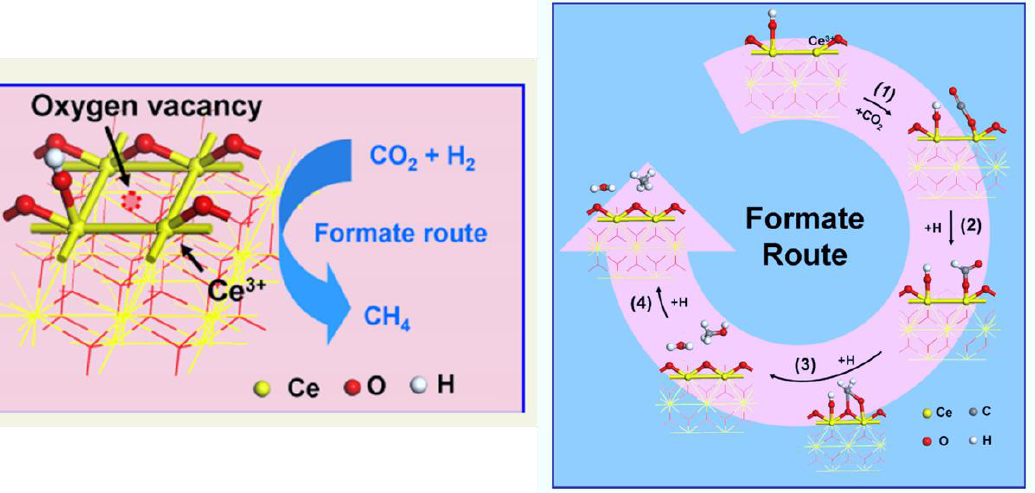
Figure 30. Schematic illustration of the formate route catalyzed by oxygen vacancies for the reaction of CO 2 methanation over Ru/CeO 2 . Reproduced with permission from Ref. [249]. Copyright© 2016, American Chemical Society.